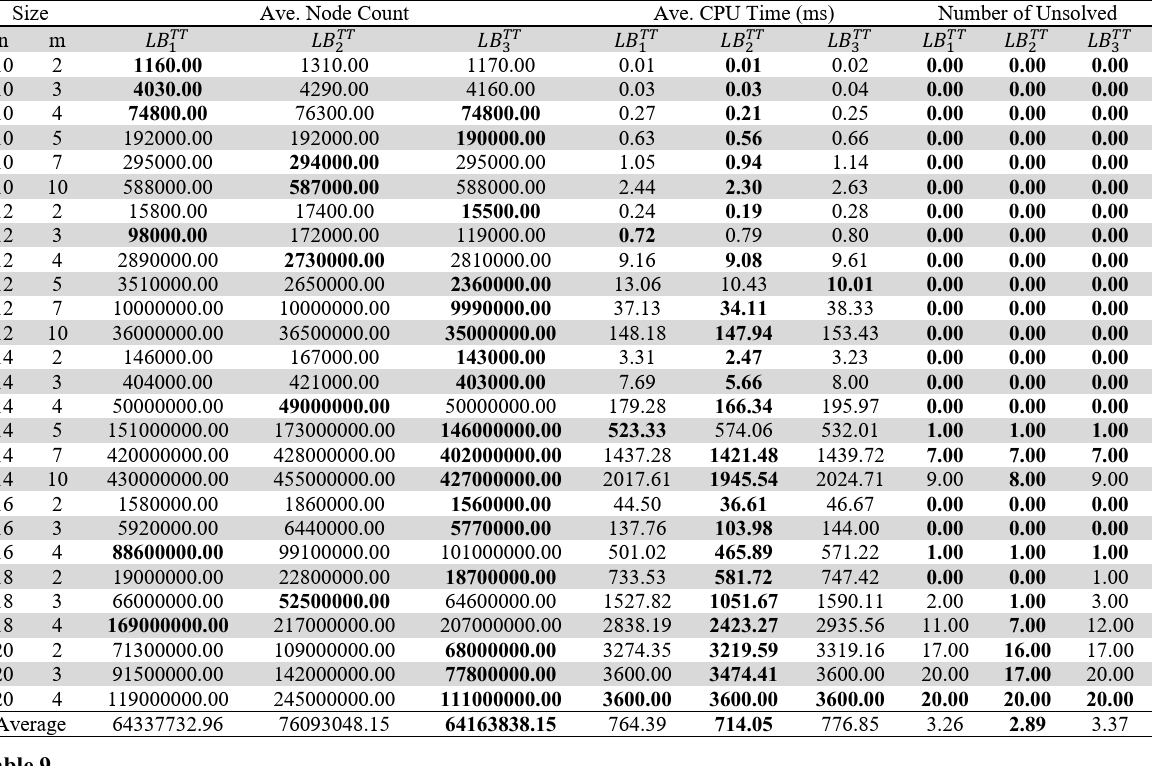
Table 9 Comparison of the variations of 𝐿𝐵 (cid:3021)(cid:3021) – Scenario